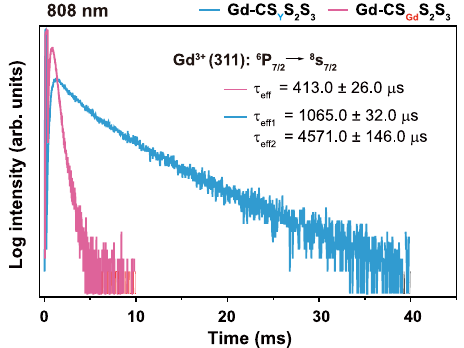
Fig. 5 Lifetime decay analysis. Upconversion luminescence decay curves of Gd 3 + emissions at 311 nm from Gd-CS Y S 2 S 3 v.s. Gd-CS Gd S 2 S 3 by pulsed 808 nm